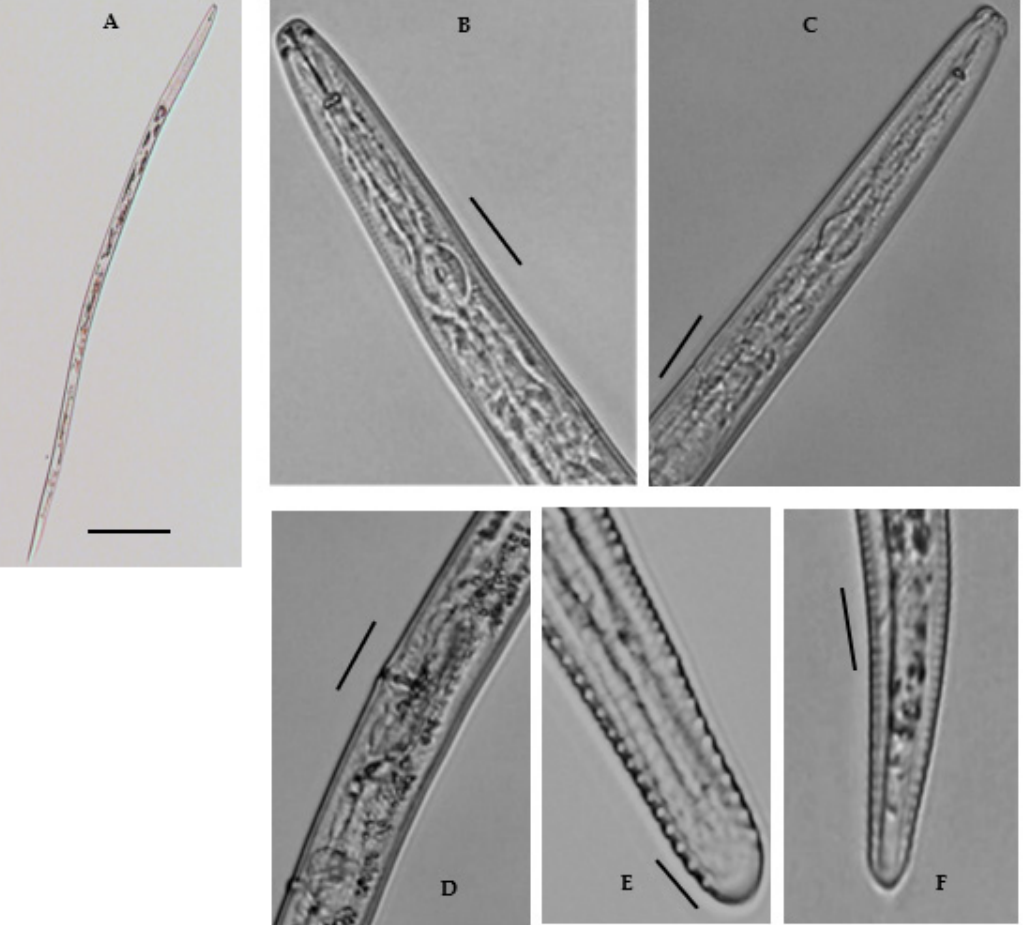
Figure 4. A Photomicrographs of female Merlinius brevidens : ( A ) entire female; ( B , C ) variation in head region; ( D ) reproductive region; ( E , F ) variation in tail region (Scale bars: ( A ) = 200 µ m; ( B – F ) = 50 µ m ) .